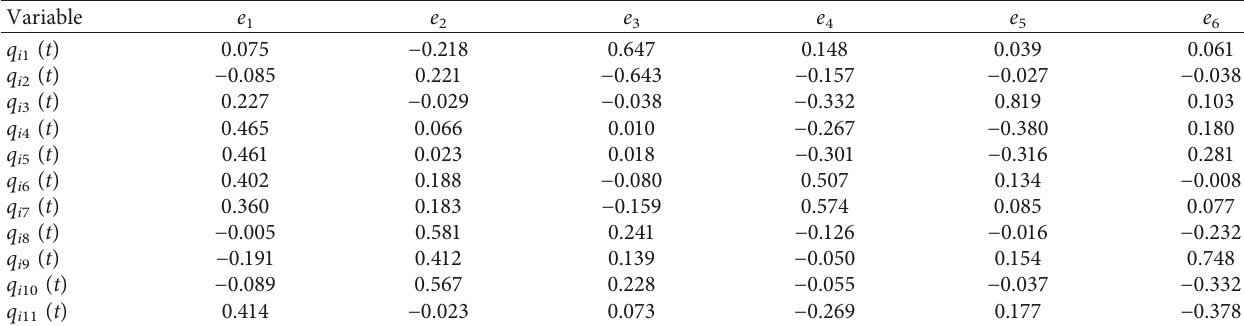
Table 4: The eigenvectors of U